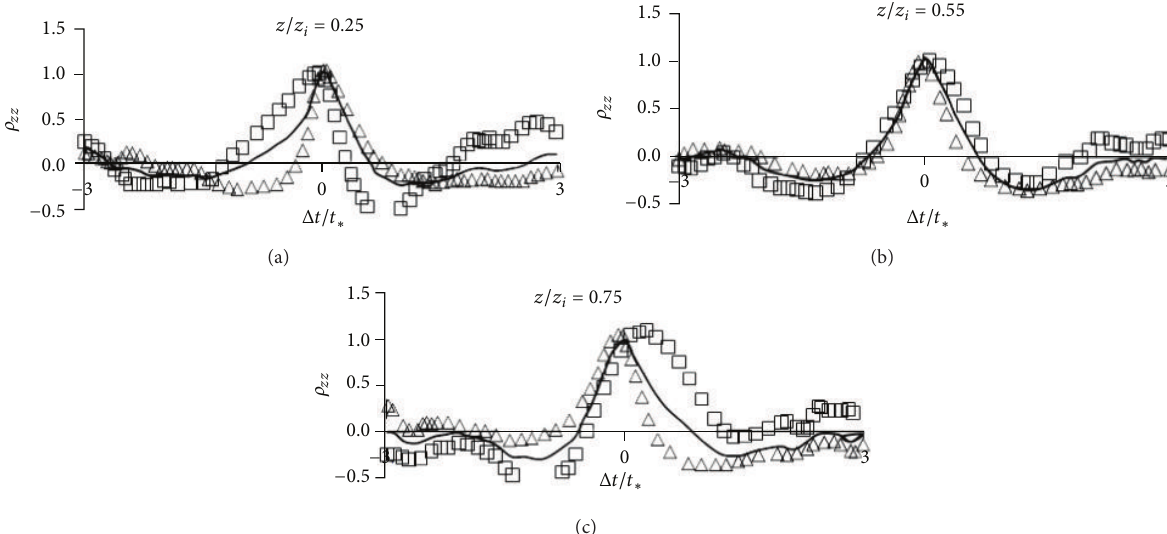
Figure 10: Lagrangian autocorrelation coefficient of the vertical velocity component, 𝜌 𝑧𝑧 , at three nondimensional heights; triangles indicate the updrafts, squares the downdrafts, and solid lines nonconditional sampling